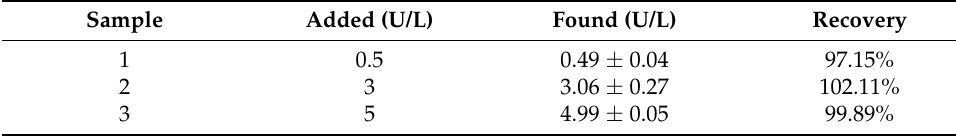
Table 2. Recovery experiments of ALP in human serum samples.